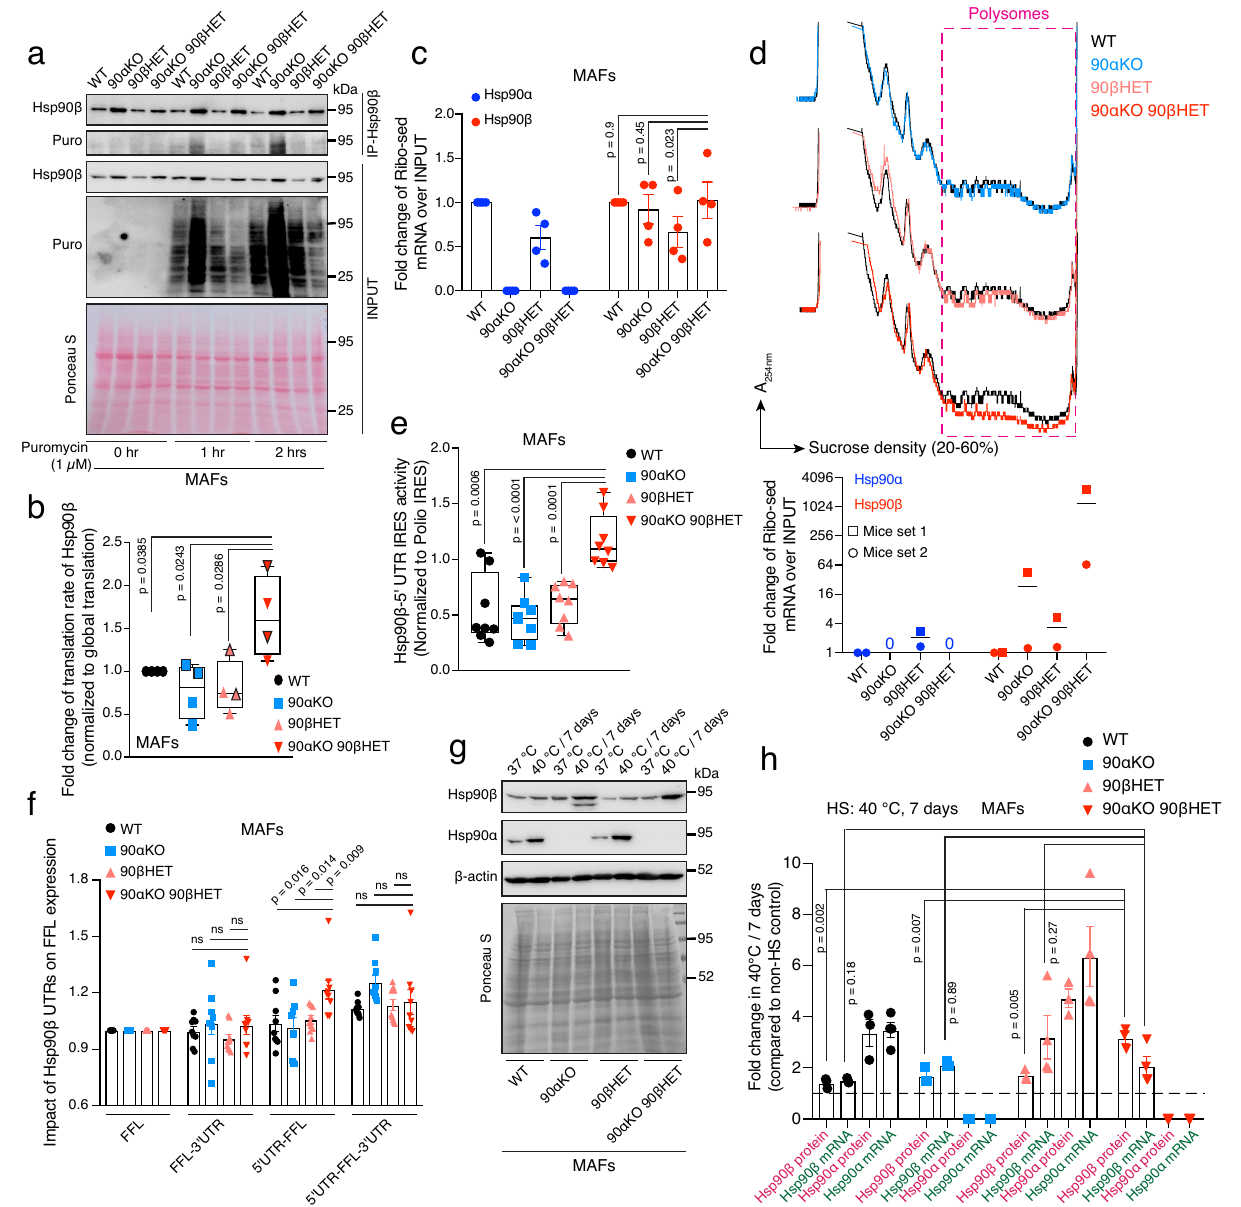
Fig.3|Increasedtranslationofthe Hsp90ab1 mRNAin90 α KO90 β